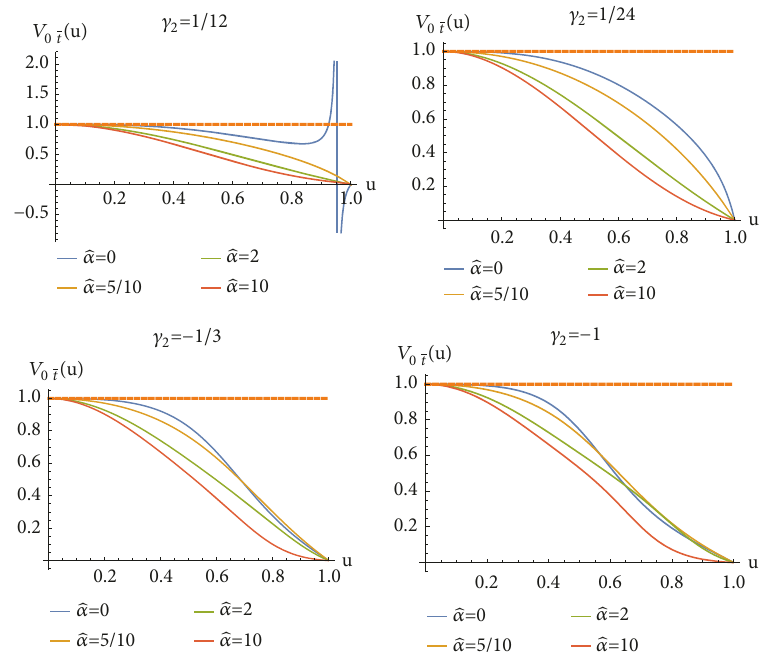
Figure 14: The potentials 𝑉 0𝑡 (𝑢) for sample 𝛾 2 and ̂𝛼 , which constrain 𝛾 2 in the region of 𝛾 2 ∈ [−∞,1/24] .